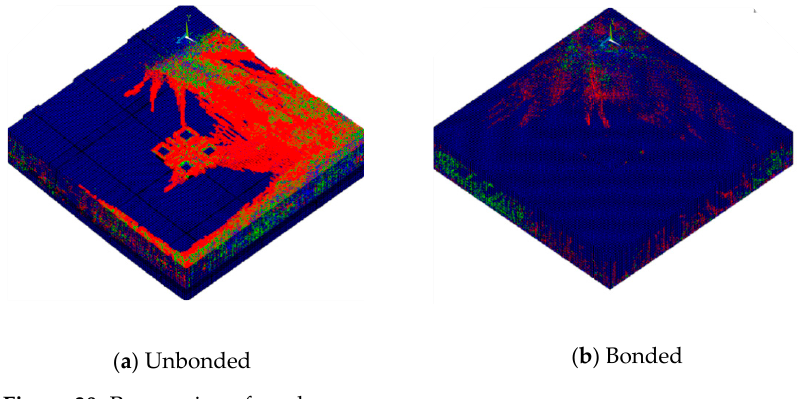
Figure 30. Progression of cracks.